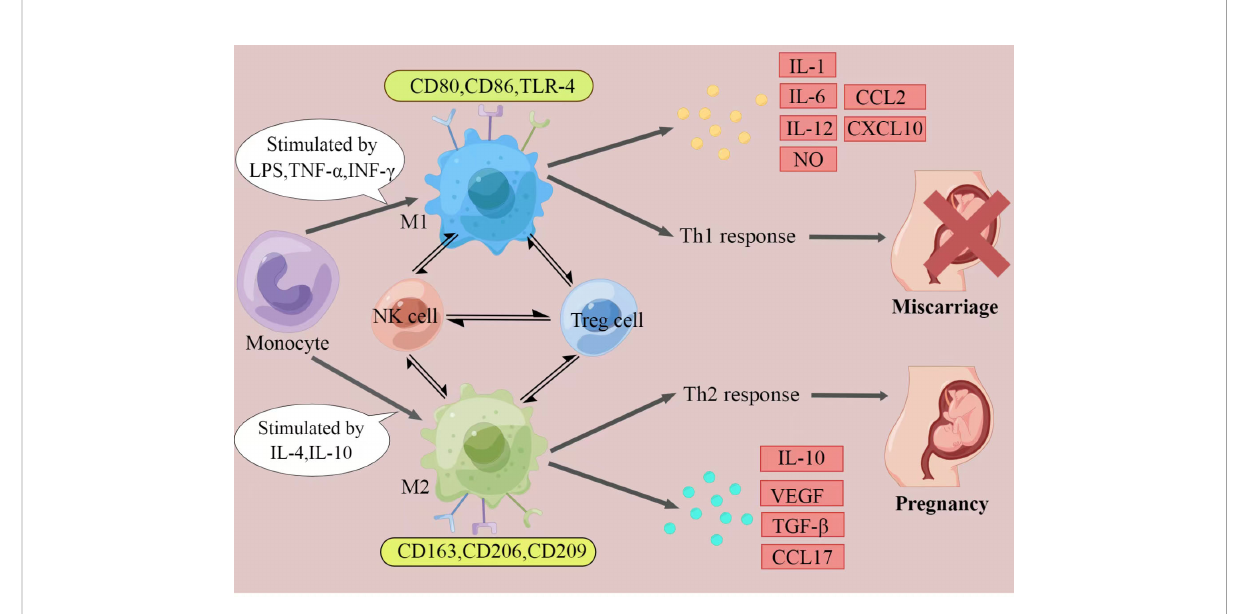
FIGURE 1 The polarization of macrophages and their characteristics. The fi gure displays a general principle of polarized M1 and M2 macrophage. M1 and M2 phenotypes represent two extremes of macrophage polarization and display distinct functions, thereby result in different pregnancy outcomes. In response to different stimuli, decidual macrophages undergo M1-like, or M2-like activation. M1 macrophages are stimulated by LPS, TGF- a , or IFN- g . They express CD80, CD86, and TLR-4, secrete IL-1, IL-6, IL-12, NO, CCL2 and CXCL10, and produce Th1 responses, exert pro-in fl ammatory effects. In contrast, M2 macrophages are activated by IL-4 or IL-10. They express CD163, CD206, and CD209, secrete IL-10, VEGF, TGF- b and CCL17, and promote Th2 responses, provide an immune-tolerant environment for the fetus. Thus, if M2 macrophages play the major role at the maternal-fetal interface, pregnancy would continue. When M1 macrophages are absolutely dominant, it will ultimately lead to miscarriage. (Created by